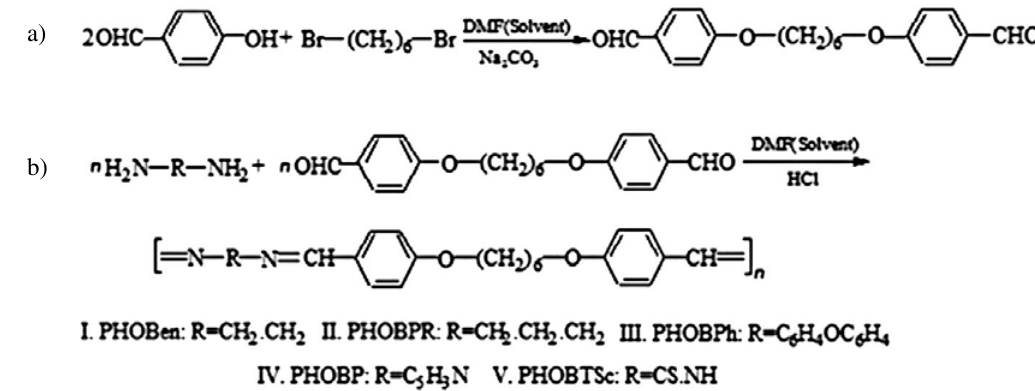
Figure 1. Reaction scheme (a) synthesis of monomer HOB and (b) synthesis of